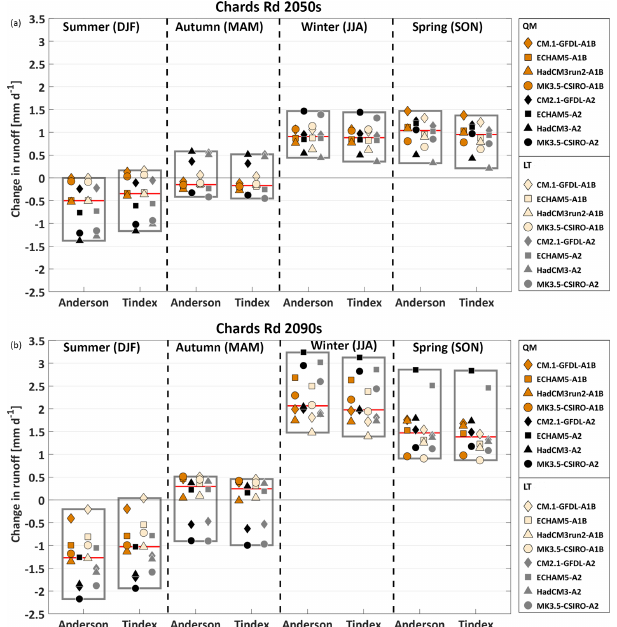
Figure 9. The uncertainty range of the seasonal runoff signal at Chards Rd is shown for (a) the 2050s and (b) the 2090s. For each season an uncertainty box is shown for WaSiM-Anderson and WaSiM-Tindex simulations, respectively. In each box (red line = median) the uncertainty range is broken down into the two emission scenarios and the two bias-correction methods (LT and